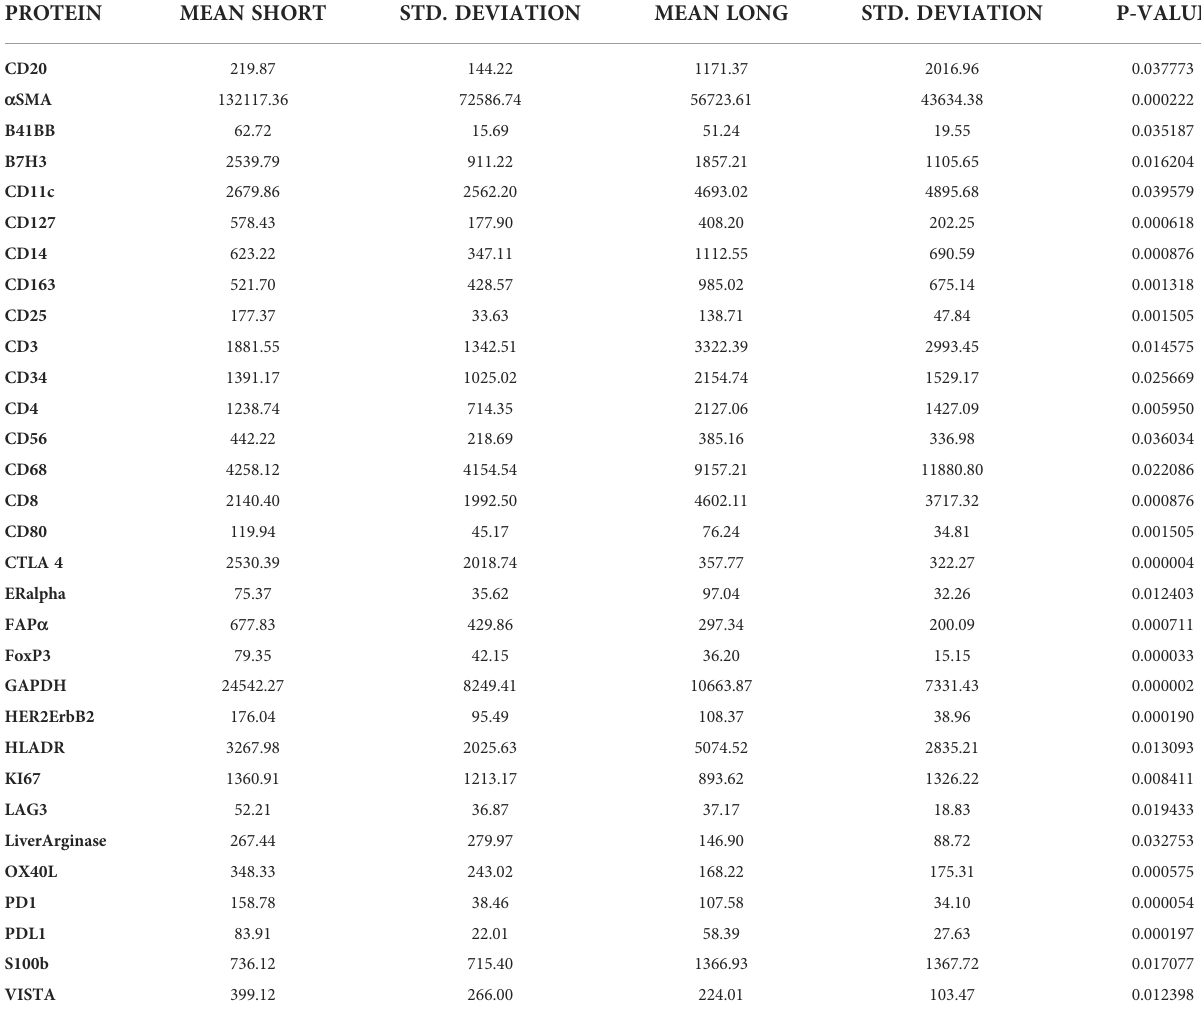
TABLE 2 Comparison of stromal ROI ’ s in the short-term (18) vs. Long-term (34) survival group. PROTEIN MEAN SHORT STD.